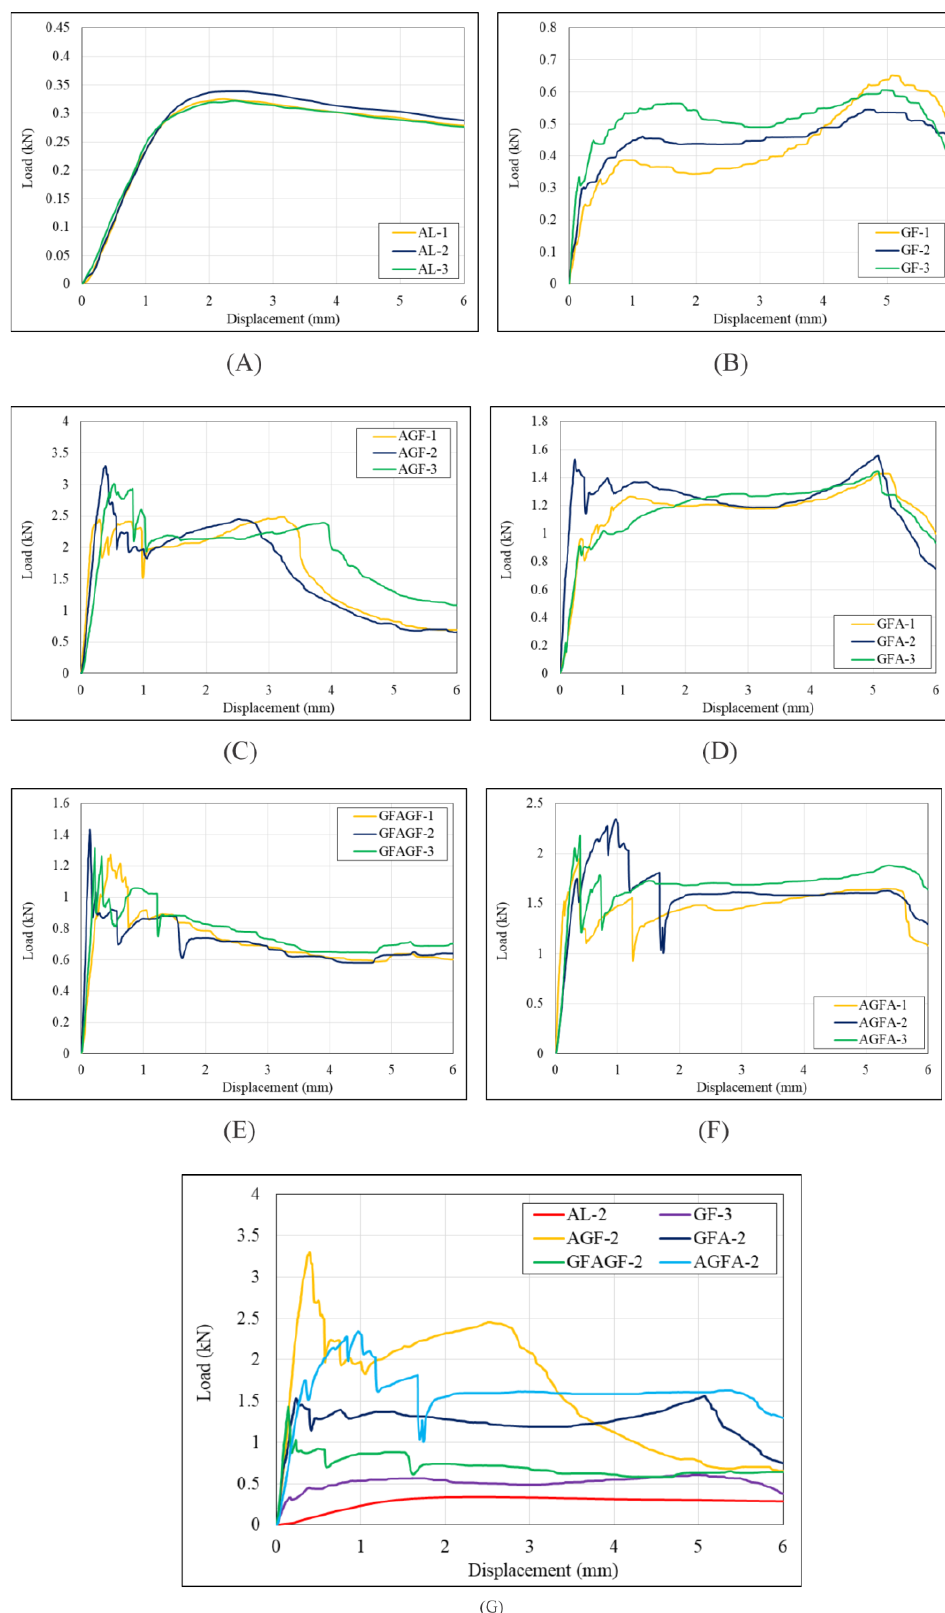
Figure 11. Lateral crashworthiness indicators of each specimen load and displacement curve of ( a ) peak crushing force (PCF), ( b ) F average, ( c ) energy adsorption (EA), ( d ) specific energy absorption (SEA), ( e ) crush force efficiency (CFE).